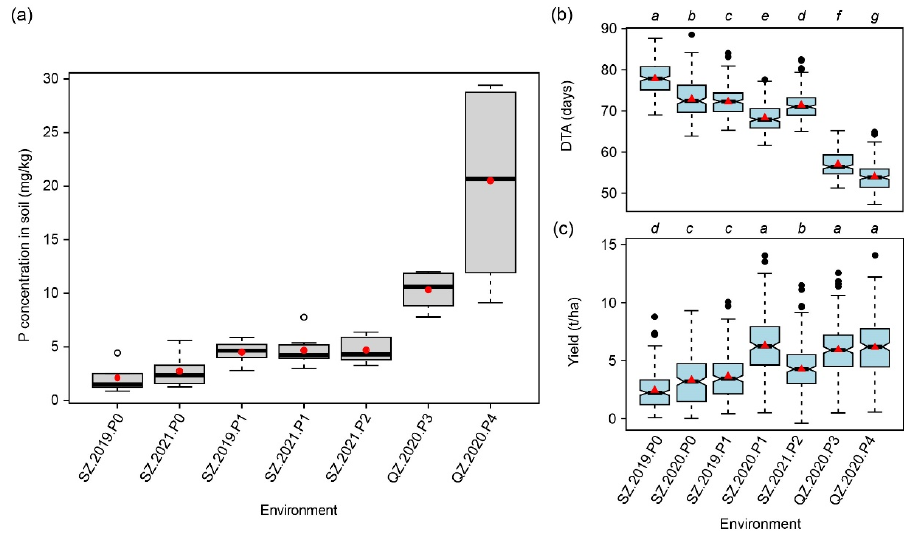
Figure 1. Soil P concentration and trait distributions. ( a ) Soil P concentration of the seven macro- environments, ( b ) distribution of days to anthesis (DTA), and ( c ) yield in these macro-environments. Multiple comparisons with letters were made by the least significant difference method at the significance level of 0.05.